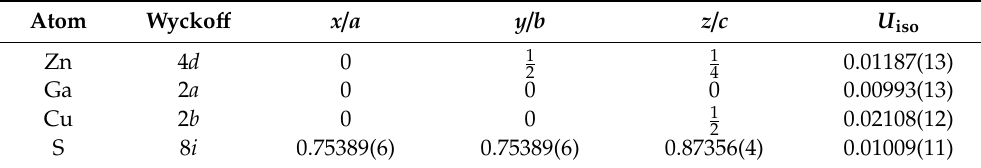
Table 5. Atoms, Wycko ff positions, atom coordinates, and isotropic displacement parameters ( U iso in Å 2 ) for richardsite.